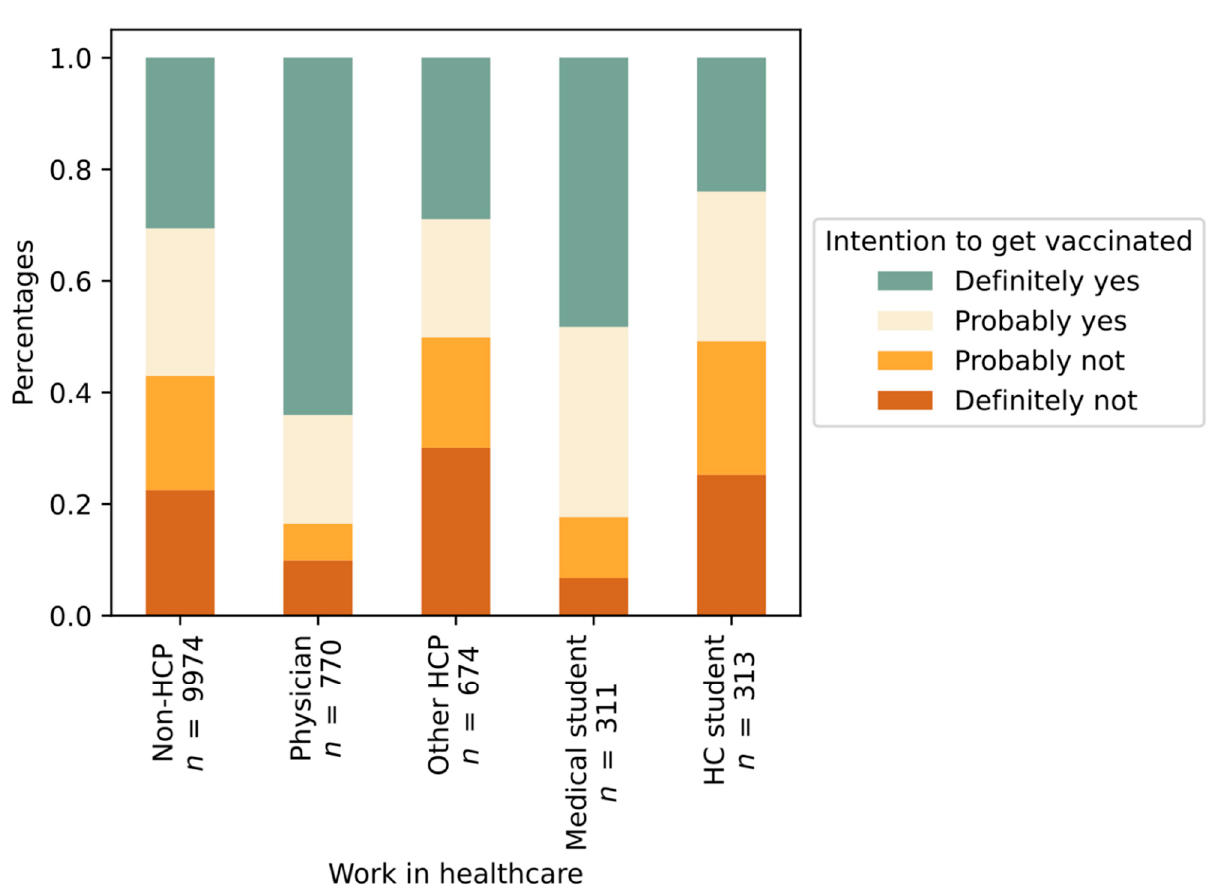
Figure 1. Intention to get vaccinated against COVID-19 grouped by working status in healthcare. More men than women definitively intended to participate in vaccination (66% vs. 55%, p < 0.001, Chi Square = 148.487 Contingency Coeff. = 0.110). Likewise, a positive attitude towards vaccination increased with age category (23% for ages 15–25 vs. 62% for 75+, p < 0.001, Chi Square = 324.499, Contingency Coeff. = 0.162) (Figure 2). In the past, only 18% of respondents had been regularly vaccinated against influenza. A strong association was observed between prior vaccination against influenza and a positive attitude towards vaccination against SARS-CoV-2 (43% vs. 78%, p < 0.001, Chi Square = 1542.675, Contingency Coeff. = 0.337) (Figure 3). Respondents who knew someone who was hospitalized or died due to the virus (44% of all respondents) were more likely to accept vaccination (66%) as compared those who did not know anyone with that experience (53%) ( p < 0.001, Chi Square = 202.946, Contingency Coeff. =